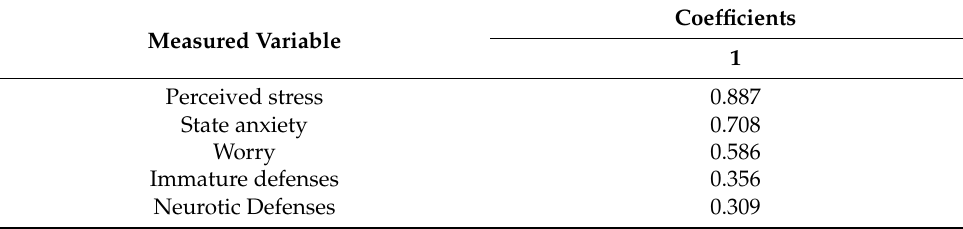
Table 3. Structure coefficients (structural